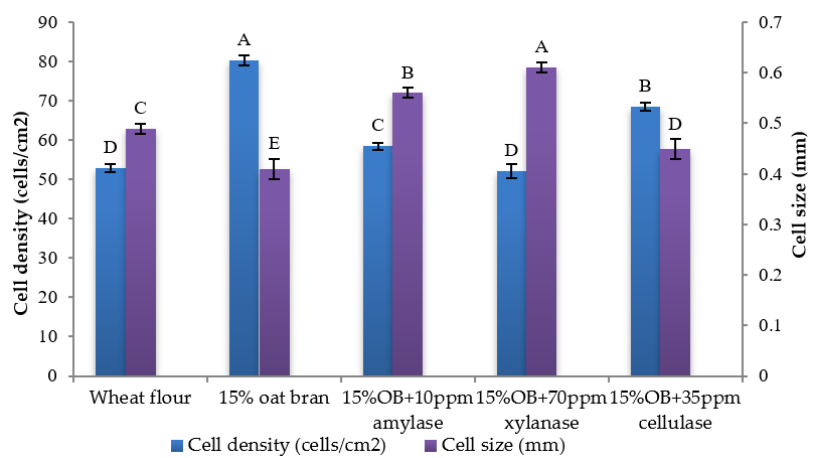
Figure 2. Textural properties of Chinese steamed bread with single enzyme.